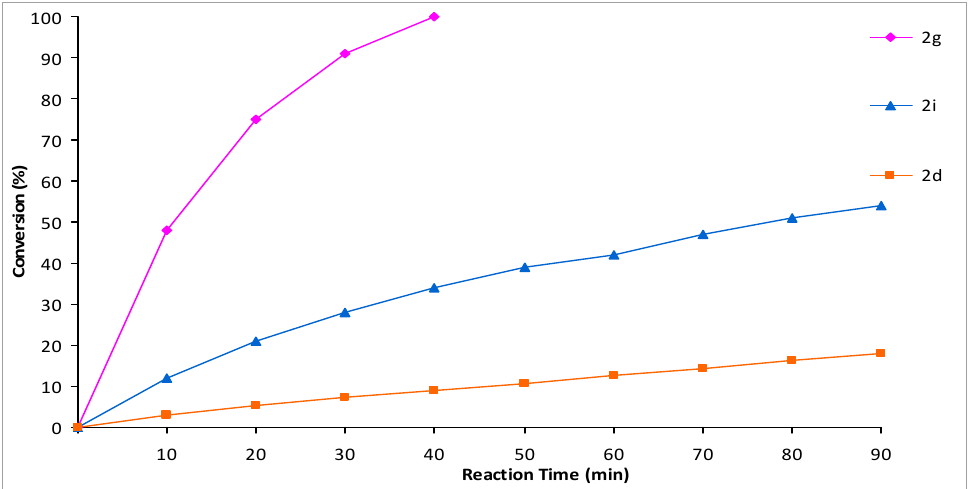
Figure 4. Studying glutathione peroxidase-like activity of compounds 2d , g , i (TBHP, BnSH, 0.1 mmol, deuterochloroform, 0.5% mol of studied compounds) by 1 H NMR monitoring.